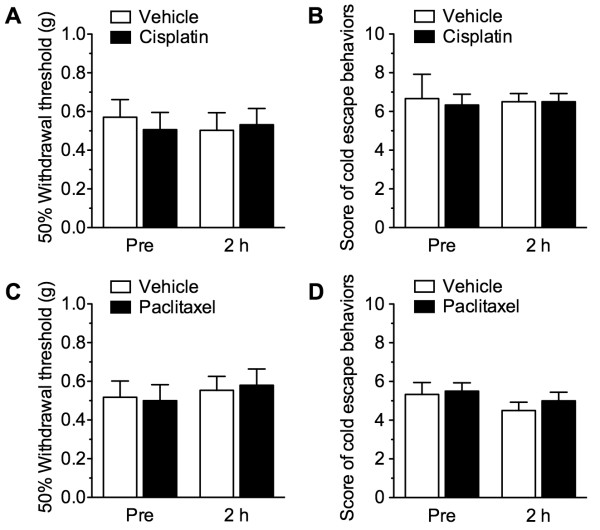
Neither cisplatin nor paclitaxel induces acute mechanical and cold hypersensitivity. Mice were intraperitoneally administered vehicle, cisplatin (5 mg/kg; A, B), or paclitaxel (6 mg/kg; C, D), and 2 h later the 50% withdrawal threshold to mechanical stimulation ( A, C) and the escape behaviors in response to cold stimulation ( B, D) were evaluated. Data are presented as the means ± S.E.M. of 6 mice.